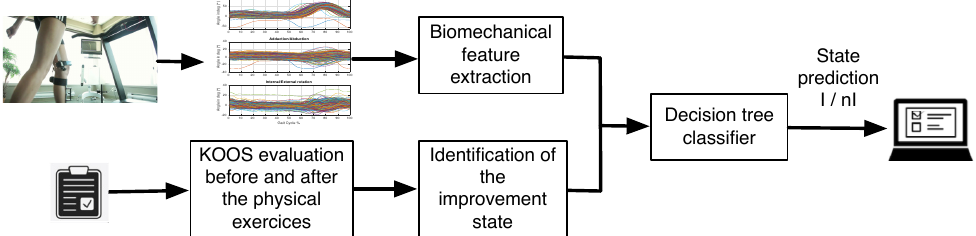
Figure 2. Block diagram of the adopted